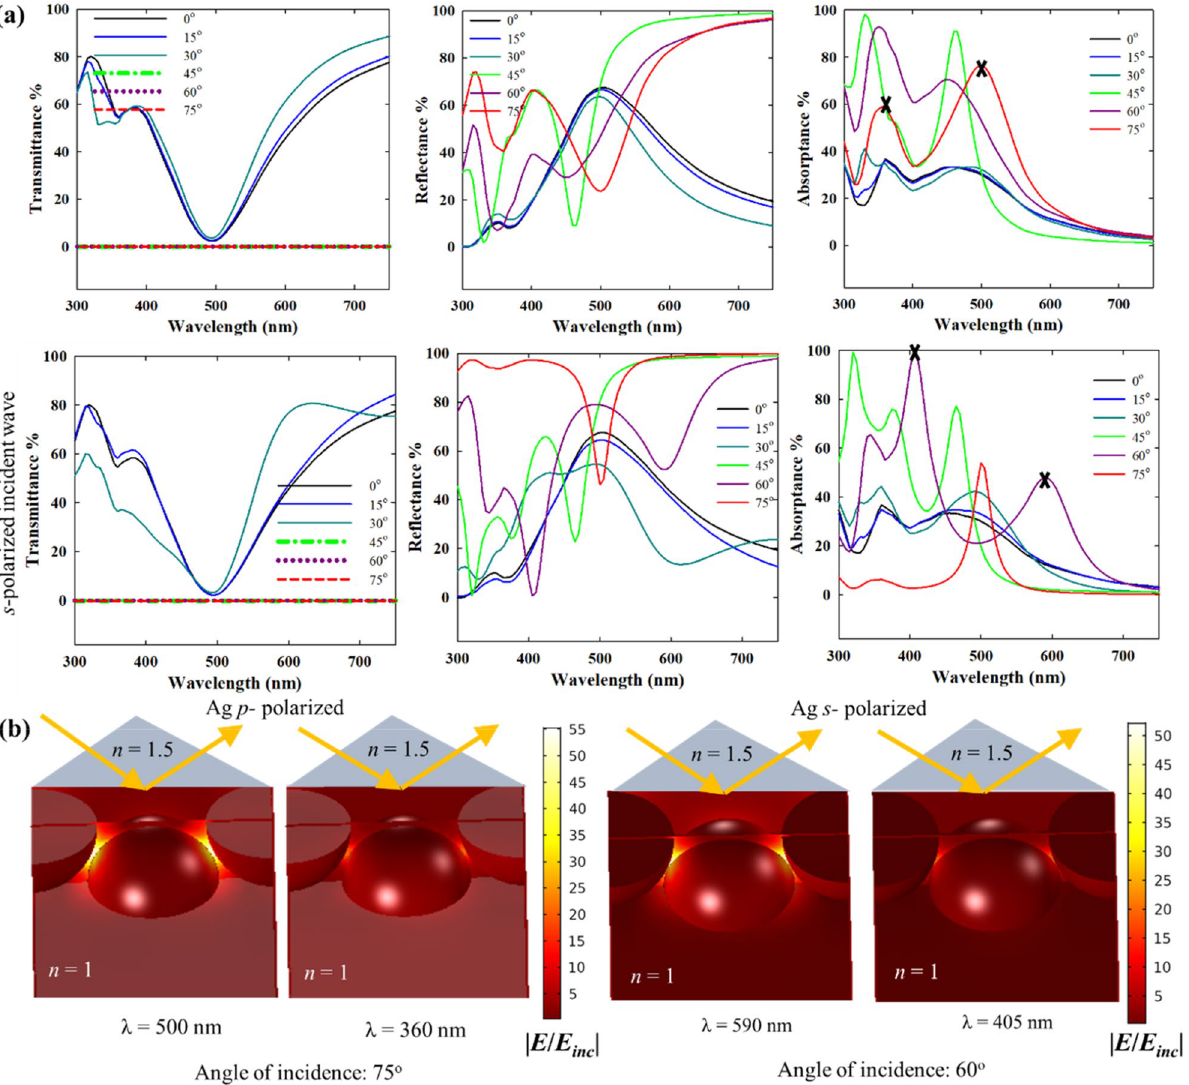
for the denser medium, n = 1 for the lighter medium and interparticle gap: 1 nm). ( b ) Near-field enhancement with respect to the background evanescent field (in absence of the nanoparticles) for p- and s -polarized (or TM and TE polarized)